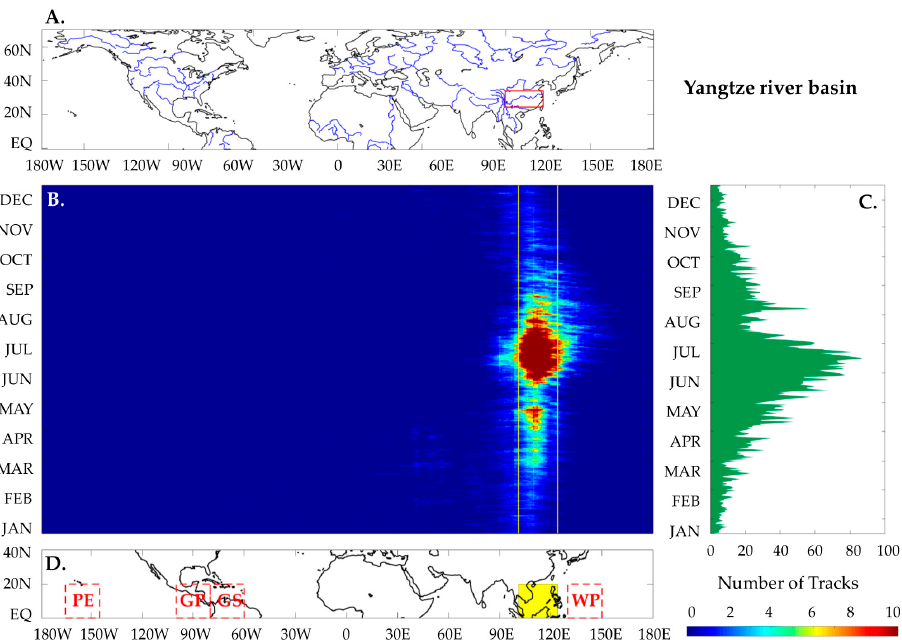
Figure 1. Tropical moisture source identification for the Yangtze river basin. Plot ( A ) shows the study area in the red box, which is used to filter the TMEs (Tropical Moisture Exports) tracks. Only those tracks entering the red box are retained to produce Plot ( B ). Plot ( B ) shows the calendar day average moisture tracks originating in the tropics [0–20° N] and entering the red box in Plot ( A ). The color scale reference bar for Plot ( B ) is on the bottom right. The band between the yellow lines in Plot ( B ) is defined by finding the yellow lines that the average annual total number of tracks starts to exceed the 95th percentile. Plot ( C ) shows the calendar day maximum and minimum numbers of tracks over the entire data period, originating within the region banded by the yellow lines in Plot ( B ). Plot ( D ) shows the four global TMEs source hotspots (‘PE,’ ‘GP,’ ‘GS’ and ‘WP’). The identified major TMEs source for the Yangtze is highlighted by the yellow box in Plot ( D ), corresponding to the banded area in Plot ( B ). Units of Plot ( B ) and Plot ( C ): number of tracks.